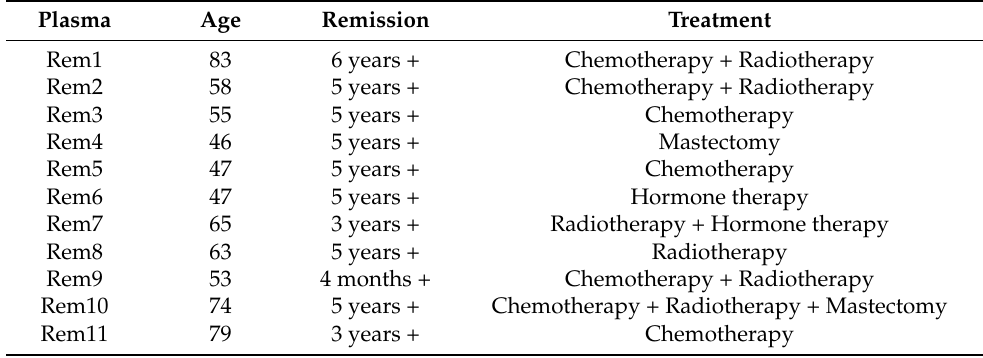
Table 3. Data from women with BC in remission.